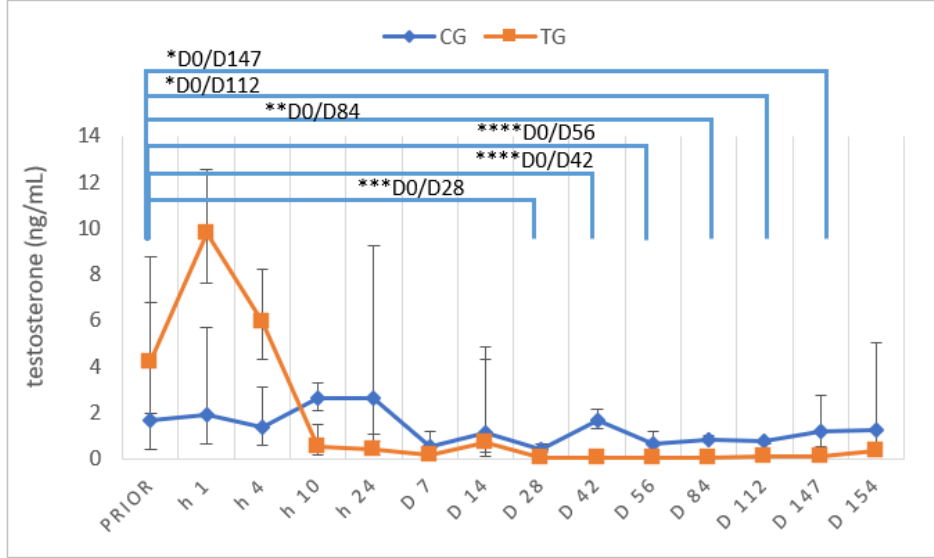
Figure 9. Plasma testosterone concentrations over time in ng/mL; given as geometric mean (x g ) and scatter range whose limits are defined by x g × dispersion factor ± 1 ; * p < 0.05, ** p < 0.01, *** p < 0.001, **** p < 0.0001; animals treated with a 4.7 mg deslorelin implant (TG, n = 6) and saline-treated control animals (CG, n = 3). “Prior” indicates “prior to